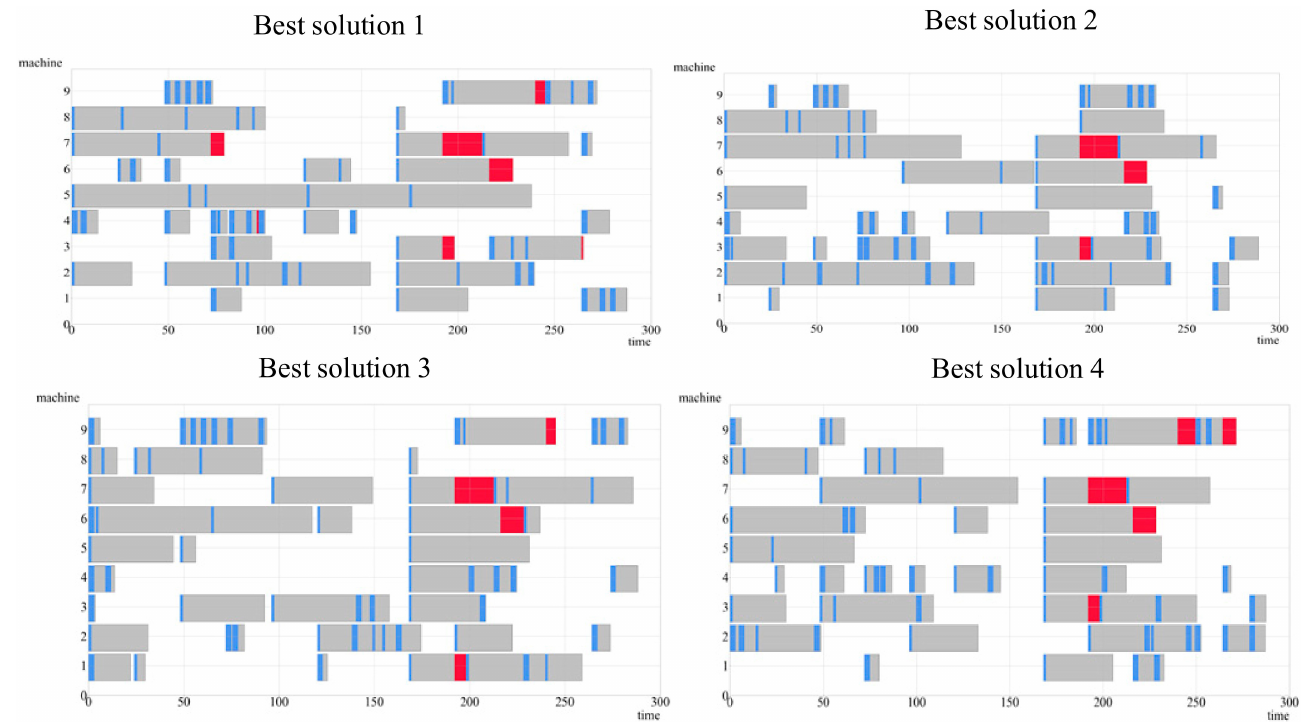
Figure 10. Gantt chart of the optimal decoding by different best solutions.